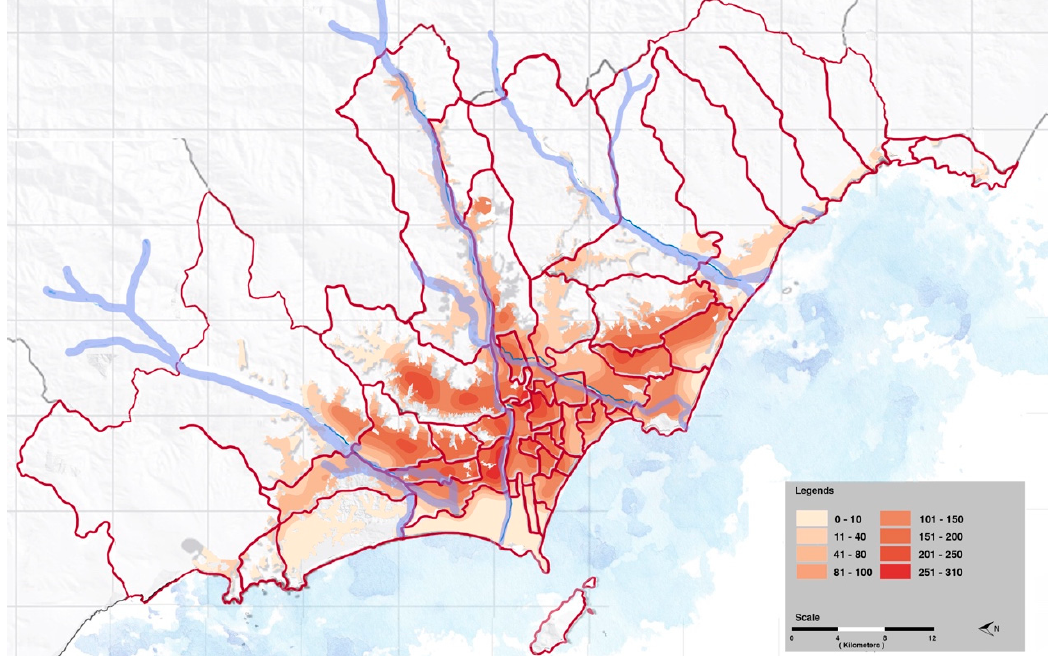
Figure 8. Densities of Lima’s urbanised area. Source: Reference [13]. Map edited by authors.